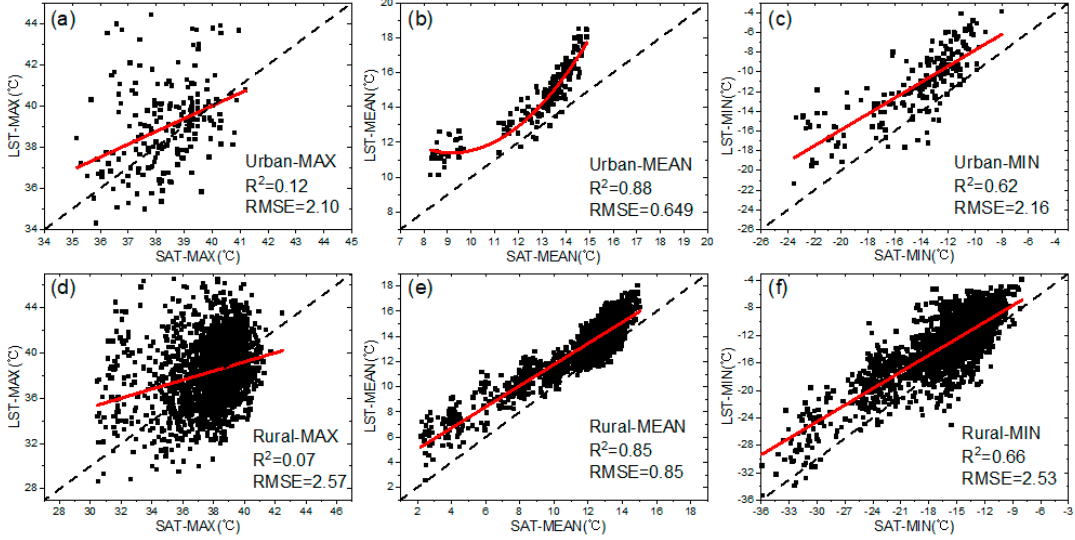
Figure 3. ( a – f ) Comparison of LST-SAT regressions between urban and rural sites.